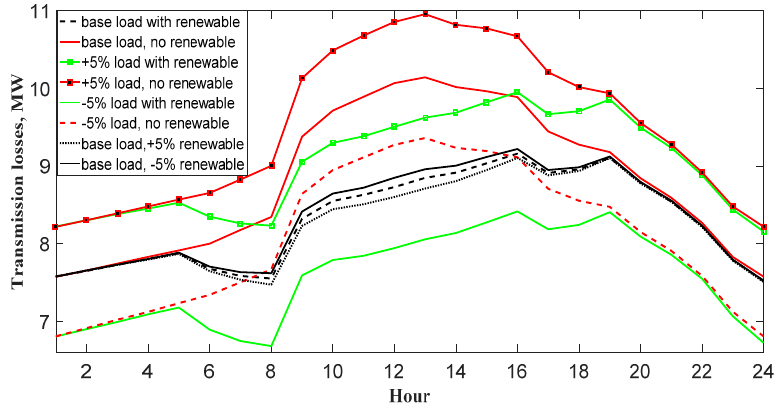
Figure 9. Effect of change in renewable energy and load in transmission losses.